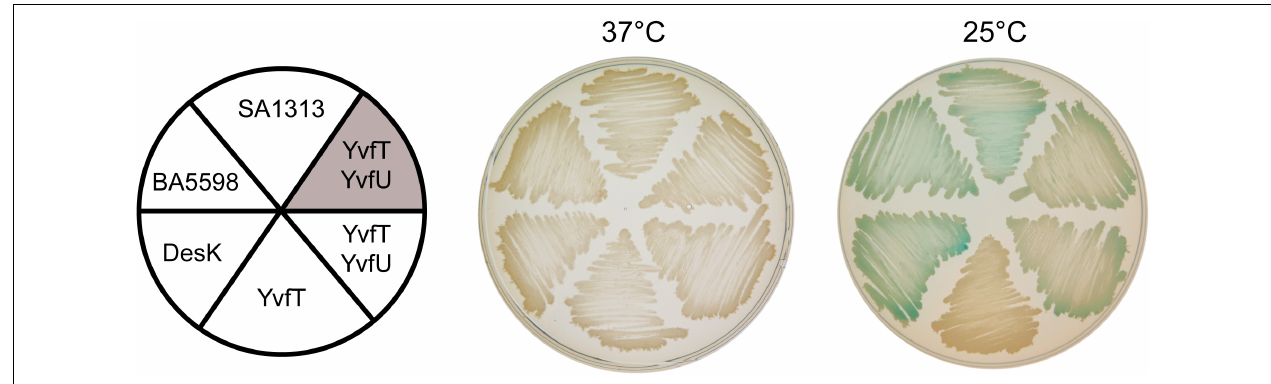
FIGURE 5 | Complementation test of desK or desK/desR null mutants. CM21 strain ( desK:Kn thrC: P xylA-desR P des-lacZ , white background) was transformed with plasmids expressing DesK, BA5598, SA1313, YvfT, or YvfT/YvfU under a xylose inducible promoter. CM28 ( desKR:Kn P des-lacZ , shaded background) was transformed with a plasmid expressing YvfT/YvfU under a xylose inducible promoter. All transformants were grown in LB plates containing X-gal 60 µ g mL − 1 and xylose 0.05%. One plate was incubated at 37 ◦ C and the other was kept at 37 ◦ C for 5 h and then transferred to 25 ◦ C for 24 h.